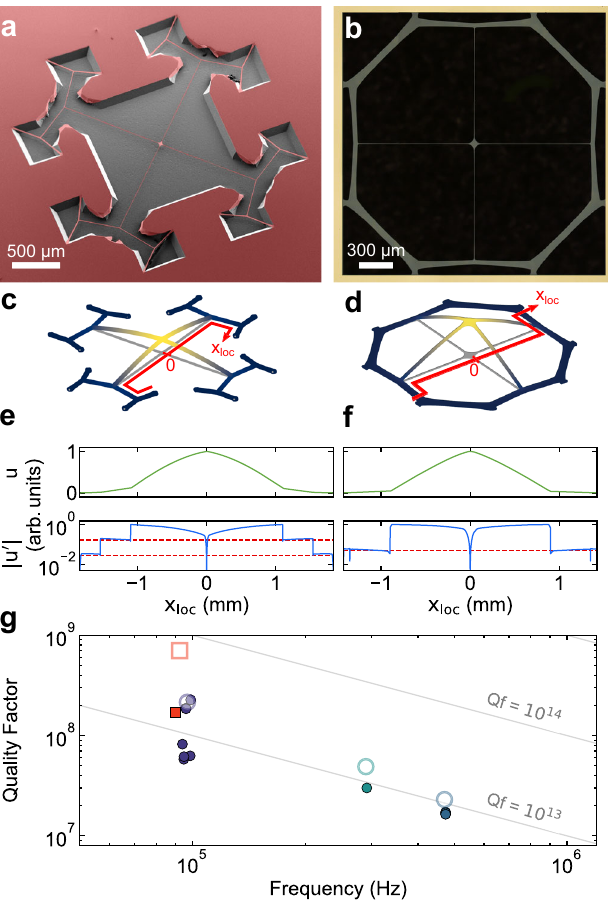
Fig. 4 Trampoline membranes with partial soft-clamping. a Scanning electron micrograph of a trampoline resonator with branching tethers. The silicon substrate is recessed by about 80 μ m below the trampoline. b Optical microscope image of a steering wheel membrane, enclosed in a square frame of about 2.2 mm side length. The silicon substrate is completely removed below the sample. c , d Simulated displacement pro fi les of the trampoline and steering wheel fundamental modes. e , f Displacement pro fi le (green) and its fi rst derivative (blue) evaluated along the red paths highlighted in c , d . The red dashed line indicates the step-like gradient suppression after a bifurcation, by a factor of cos ð θ Þ . g Measured quality factors of self-similar and steering wheel trampolines. Squares represent trampolines with branching tethers, while circles corresponds to steering wheels. Colors differentiate distinct designs. Measurements of individual devices are displayed with fi lled symbols, while open symbols portray the Q factors predicted with a fi nite element model. supports along the slow-etching planes (see Fig. 6a). In this case the silicon at the clamping points is protected during the KOH etch since only the slow-etching planes are exposed. The results reported in the main text were obtained for binary tree resonators based on this approach. It should be noted that the rotation of the supports inevitably leads to non-orthogonal clamping of the fi nal beam segments causing a deviation from the ideal clamping conditions assumed in our model. This boundary geometry induces limited changes to the frequencies and dissipation rates of the lower order modes due to their limited mode amplitudes at the clamps, as con fi rmed by fi nite-element simulations. The increase in dissipation is small in comparison with the deleterious effect of a signi fi cant overhang at the supports. Trampoline membrane resonators . Trampoline membranes with branching tethers are fabricated similarly to binary-tree beam resonators. The overall process follows the one described in the Supplementary Material of ref. 18 and in ref. 45 ; here, we highlight the main differences with respect to the fabrication process of binary-tree beams. After patterning and etching the outline of the membrane resonators on the front side Si 3 N 4 layer with e-beam lithography, we exploit the Si 3 N 4 layer